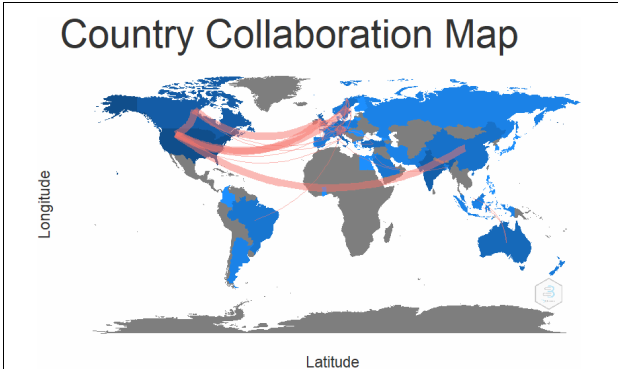
FIGURE 5 | Collaboration between countries.